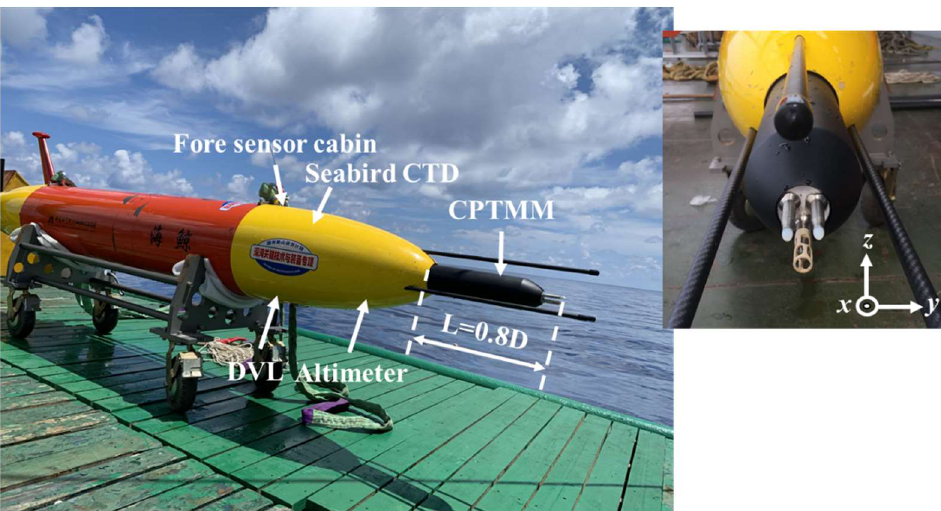
Figure 5. Photograph of the Sea-Whale 2000 AUV with the CPMTM and other oceanographic sensors. The CPMTM is housed in the center of the fore sensor cabin with the shear probes ahead of the nose by 0.8 diameters. Detailed diagram showing the location of the microstructure probes in the upper right corner.